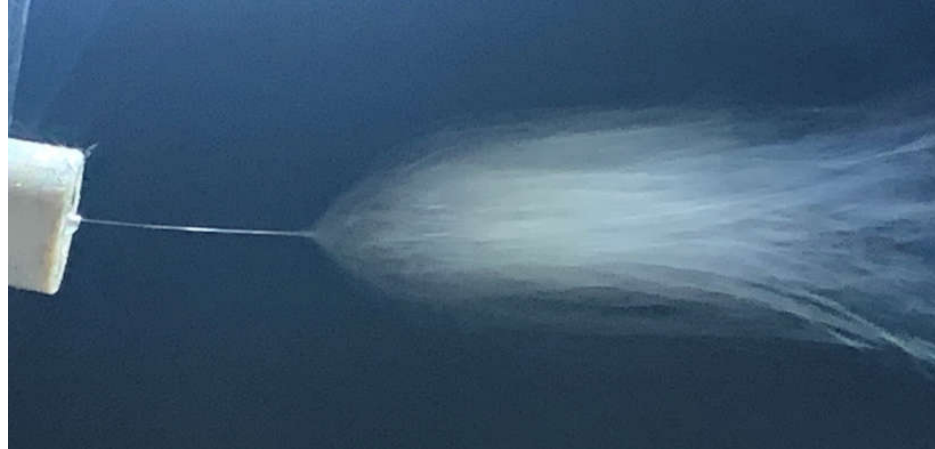
Figure 4. Electrospinning jet